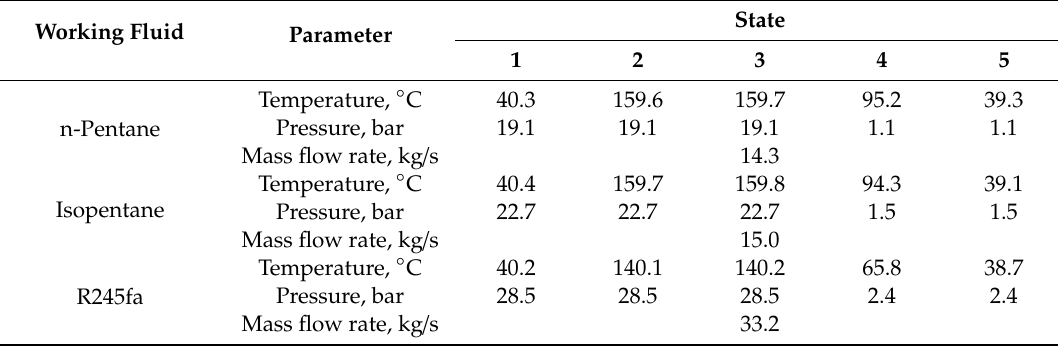
Table 2. The Initial Conditions for All Working